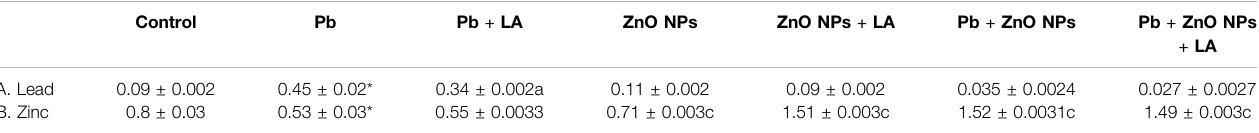
TABLE 2 | Blood metal level (µg/ml blood) in rats. (A) Lead. (B) Zinc. All the values are expressed as mean ± SEM (n (cid:2) 5). The statistical signi fi cance was considered at p < 0.05, and statistical analysis was performed using one-way ANOVA, followed by Tukey ’ s test. * p < 0.05, p < 0.05 vs. lead; c p < 0.001 vs. ZnO NPs; b p < 0.01 vs. Pb + ZnO